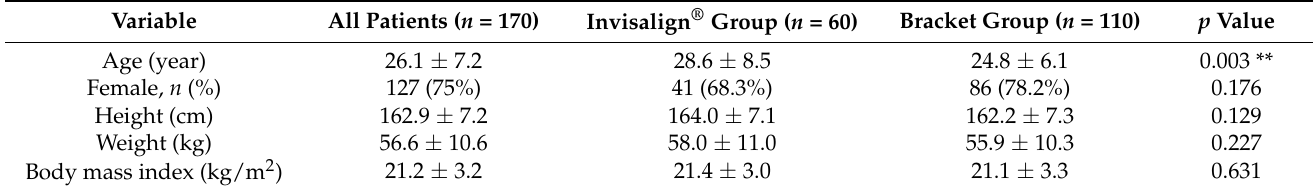
Table 2. Baseline demographics of patients, stratified by orthodontic device (Invisalign ® or bracket) ( n = 170).